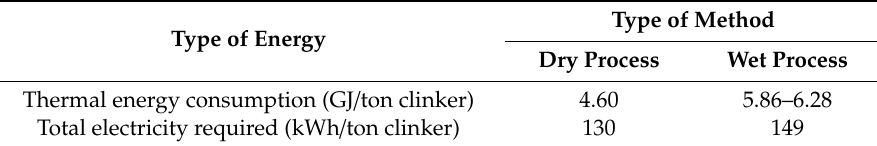
Table 1. Total thermal and electrical energy consumption in dry and wet process [39,40].